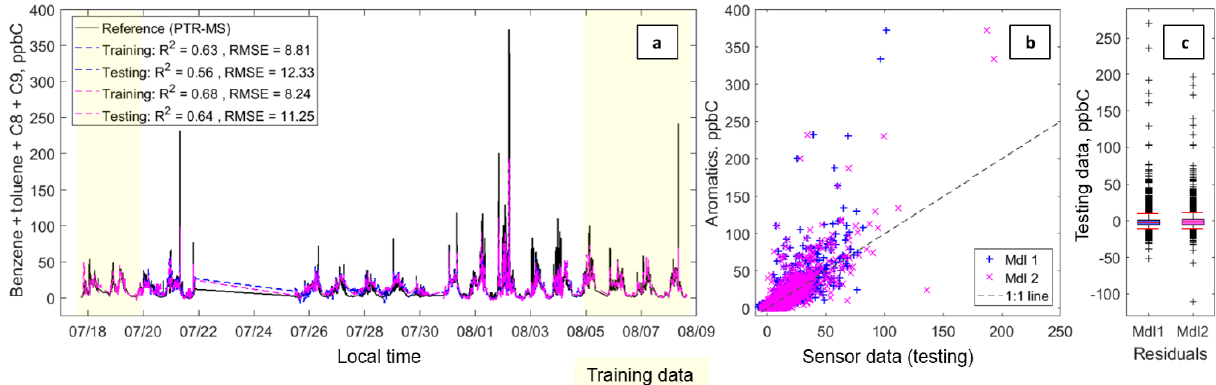
Figure 3. Panel (a) depicts a time series including the summed aromatic data from the PTR-QMS (benzene, toluene, C 8 and C 9 alkylben- zenes), and the fitted sensor data from Model 1 (in blue) and Model 2 (in fuchsia). The text box includes the following statistics: coefficient of determination ( R 2 ) and the root-mean-squared error (RMSE) in that order for each testing and training dataset. Panel (b) depicts a scatter plot of the testing data for Model 1 (in blue) and Model 2 (in fuchsia); the 1:1 line has also been added. Panel (c) depicts box plots of the residuals with the whiskers at the fifth and 95th percentiles (in